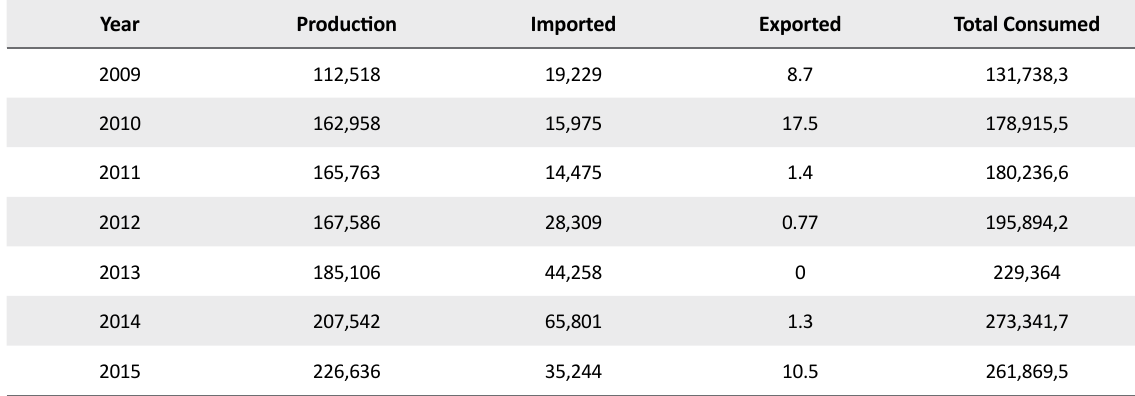
Table 2. Batteries produced, imported, and exported from 2009 to 2015 (Ton/Year)